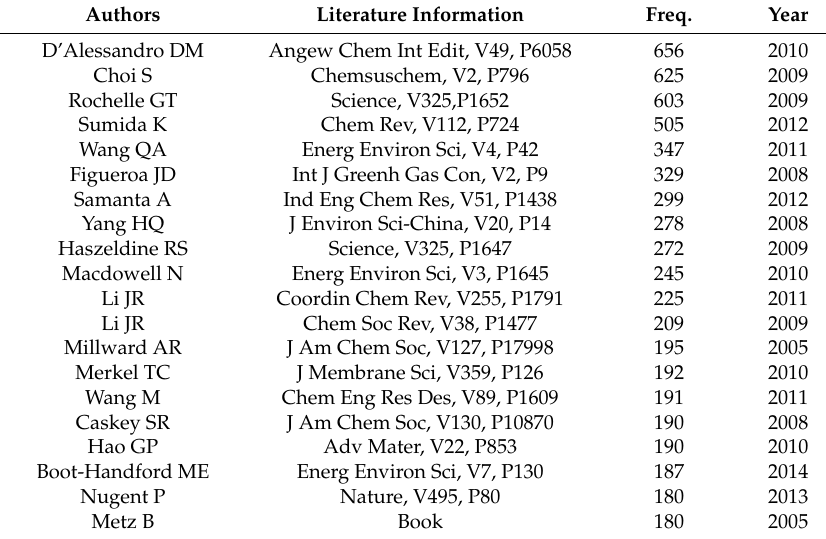
Table 3. Top 20 references in the research area of CCS technology.